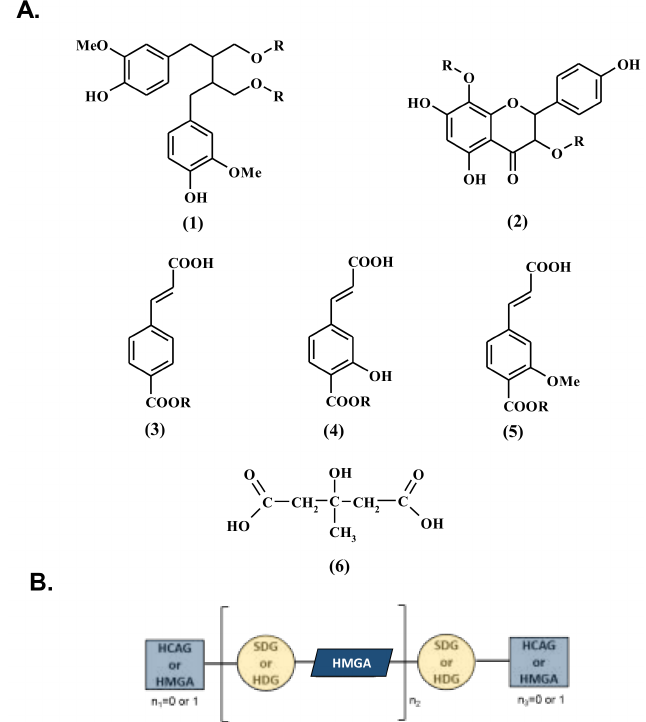
Figure 1. Structure of phenolic compounds involved in the lignan macromolecular complex. ( A ) Structure of the complex components: ( 1 ) secoisolariciresinol (R = H), or secoisolariciresinol diglucoside (SDG, R = β - D -glucose), ( 2 ) herbacetin (R = H) or herbacetin diglucoside (HDG, R = β - D -glucose), ( 3 ) p -coumaric acid (R = H), or p -coumaric acid glucoside (CouG, R = β - D -glucose), ( 4 ) caffeic acid (R = H) or caffeic acid glucoside (CafG, R = β - D -glucose), ( 5 ) ferulic acid (R = H) or ferulic acid glucoside (FerG, R = β - D -glucose), ( 6 ) hydroxymethylglutaric acid (HMGA). ( B ) Schematic representation of lignan macromolecule, where a unit of SDG or HDG is ester-linked to another unit, thanks to HMGA, which can be replaced by one hydroxycinnamic acid glucoside (HCAG) unit (CouG, CafG, or FerG) in terminal position of the